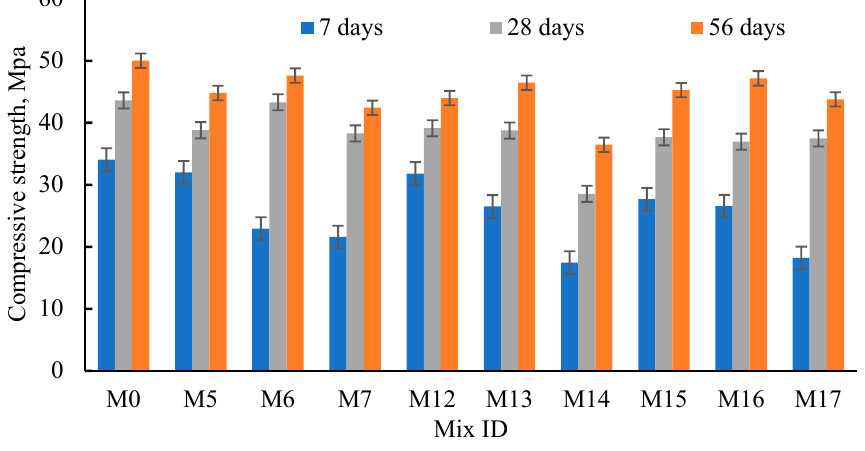
Figure 7. Effect of the RCP, AMF, and SF contents on concrete compressive strength.